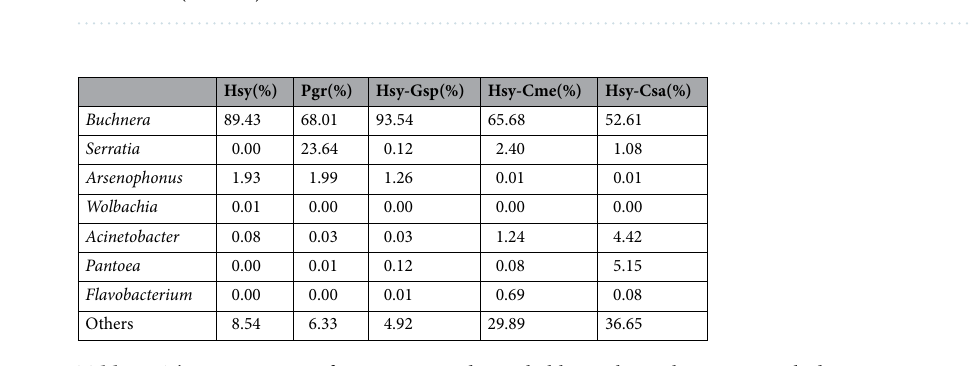
Table 2. The proportions of 4 common and 3 probable symbiotic bacteria in aphids among Hsy, Pgr, Hsy-Gsp, Hsy-Cme and Hsy-Csa.